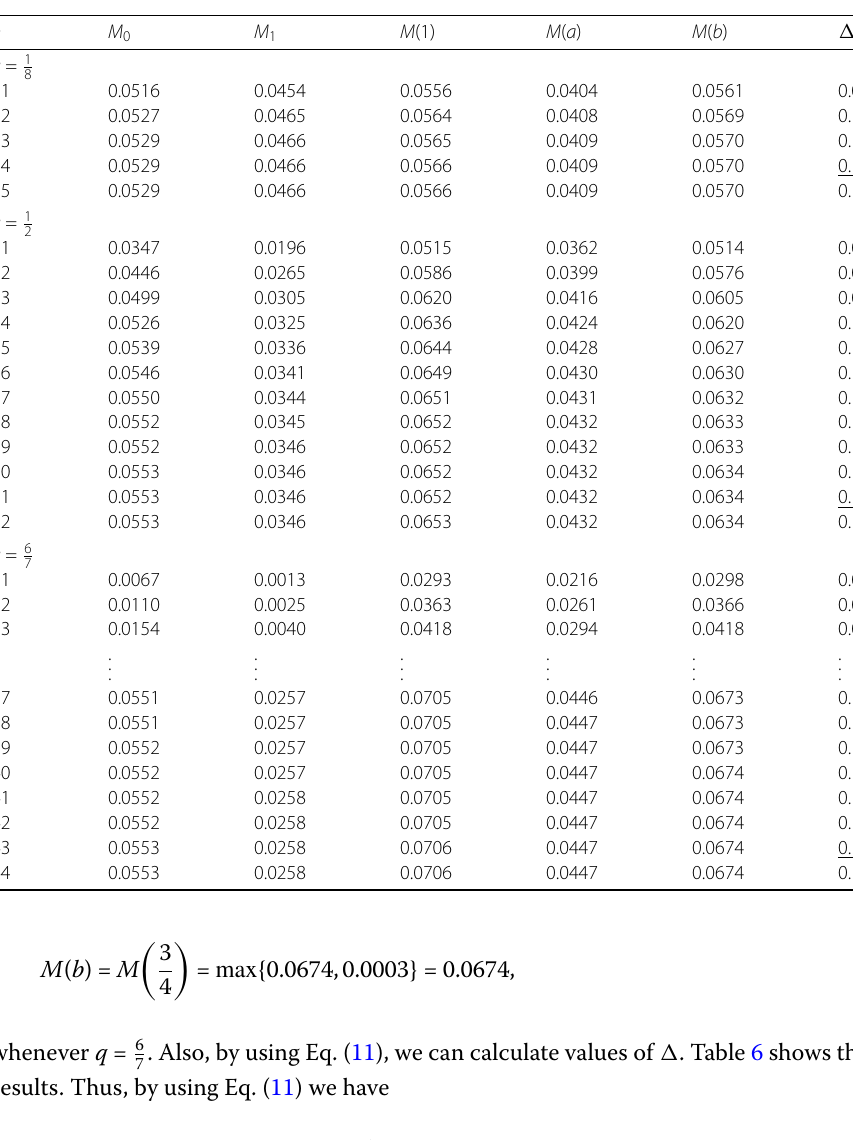
Table 6 Some numerical results for calculation of M 0 , M 1 , M (1), M ( a ), M ( b ) and (cid:13) < 1 in Example 1 , 1 , 6 for q = 1 8 2